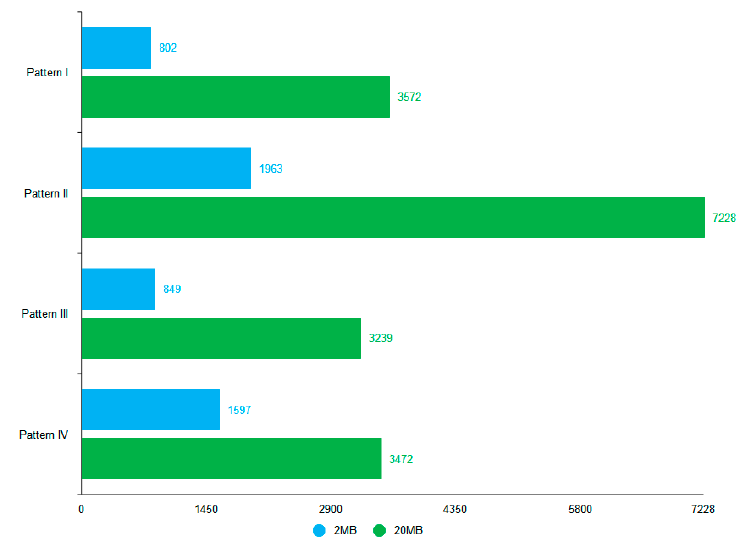
Figure 14. Histogram of time consumption of data storage in the four patterns with different file sizes.